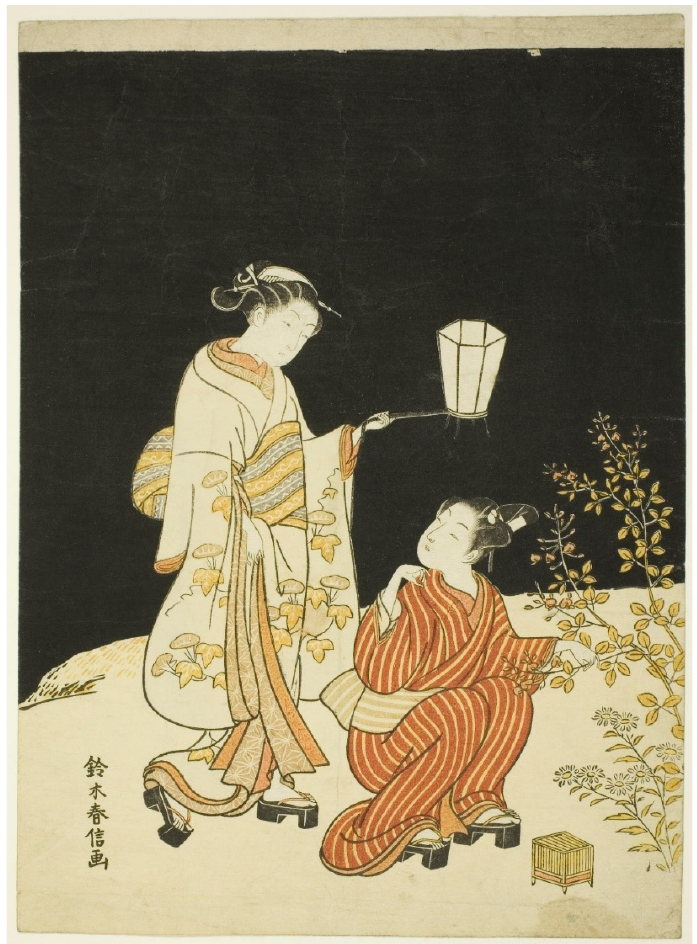
Figure 10. (T30). Searching for Fireflies. ca. 1768. Suzuki Harunobu (Japanese, 1725–1770). Color woodblock print, chūban. Clarence Buckingham Collection. Reference Number: 1952.327. The Art Institute of Chicago, IL USA, https://www.artic.edu/artworks/77297/searching-for-fireflies (accessed on 4 January 2022). Open access image, CC0.